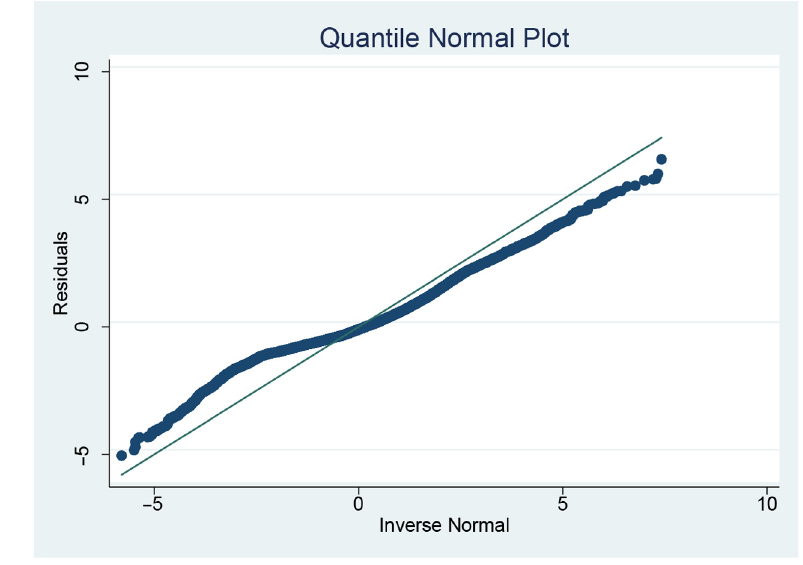
Figure 1. Quantiles of the residuals plotted against the quantiles of the normal distribution for OLS regression